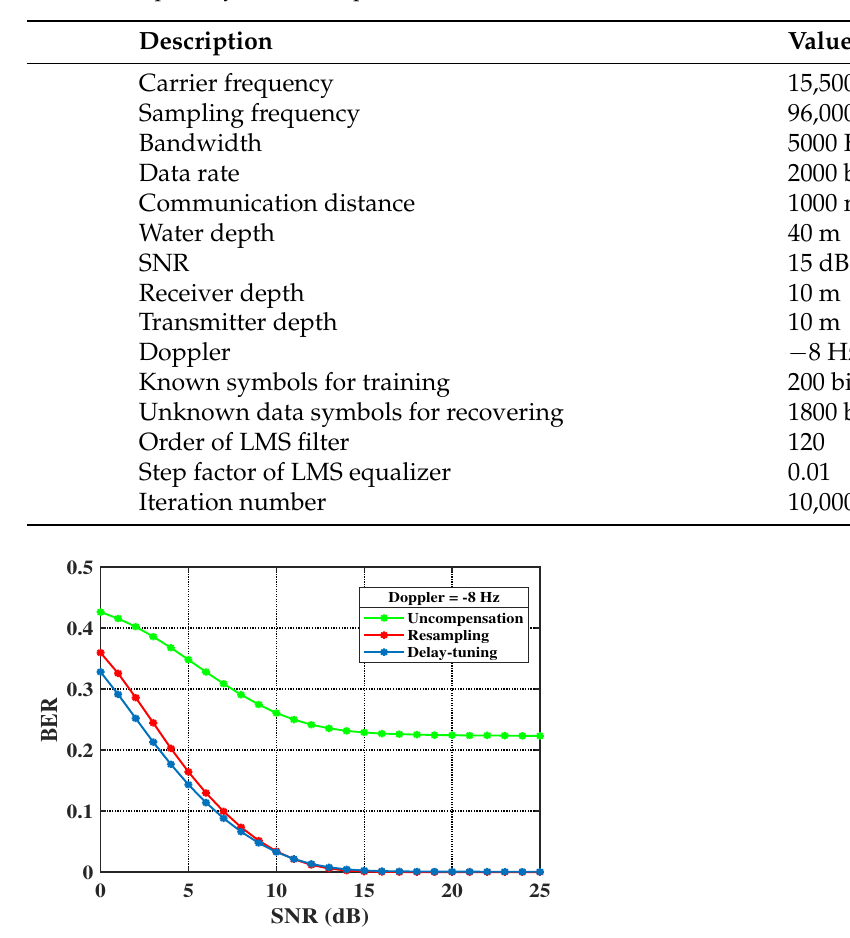
Figure 5. The BER outputs of different communication schemes under different SNR at Doppler = − 8 Hz.